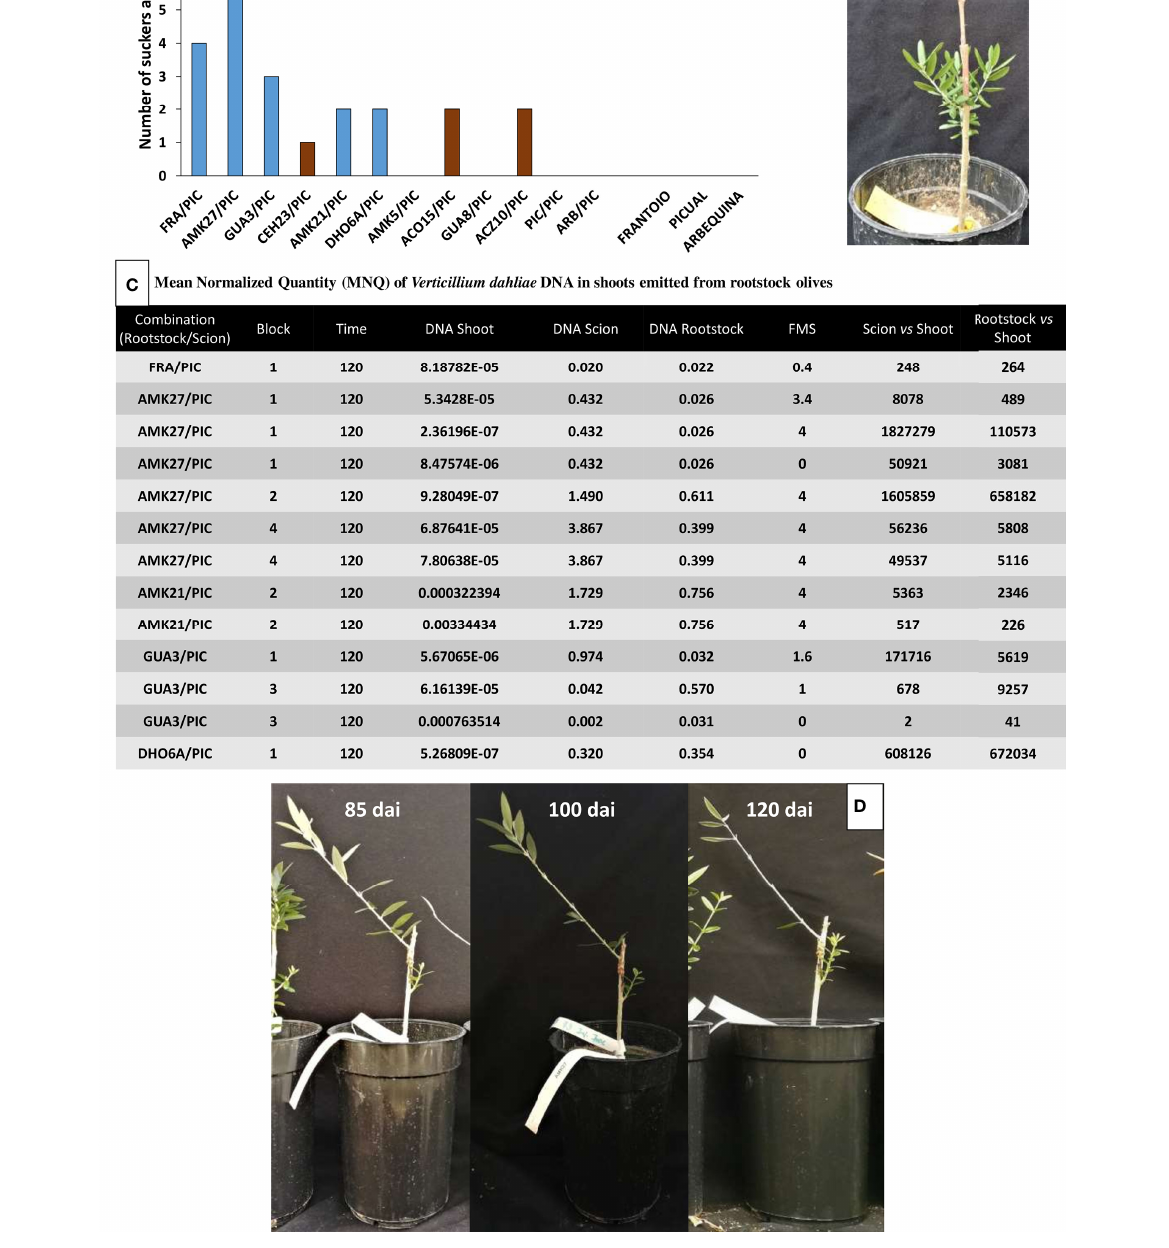
FIGURE 8 Number of rootstock suckers for each genotype at 120 days after inoculation (dai) (Blue bars correspond to alive suckers and brown bars correspond to dead suckers) (A) . Example of an inoculated AMK27 plant at 120 dai showing dead ‘ Picual ’ scion and asymptomatic suckers grown from the rootstock (B) . Mean Normalized Quantity (MNQ) of Verticillium dahliae DNA in rootstock suckers at 120 dai with the V. dahliae defoliating isolate VD117 (C) . Examples of inoculated AMK27/PIC plants at 85, 100 and 120 dai, showing severity of symptoms (defoliation and necrosis) on ‘ Picual ’ scion and asymptomatic rootstock suckers (D)